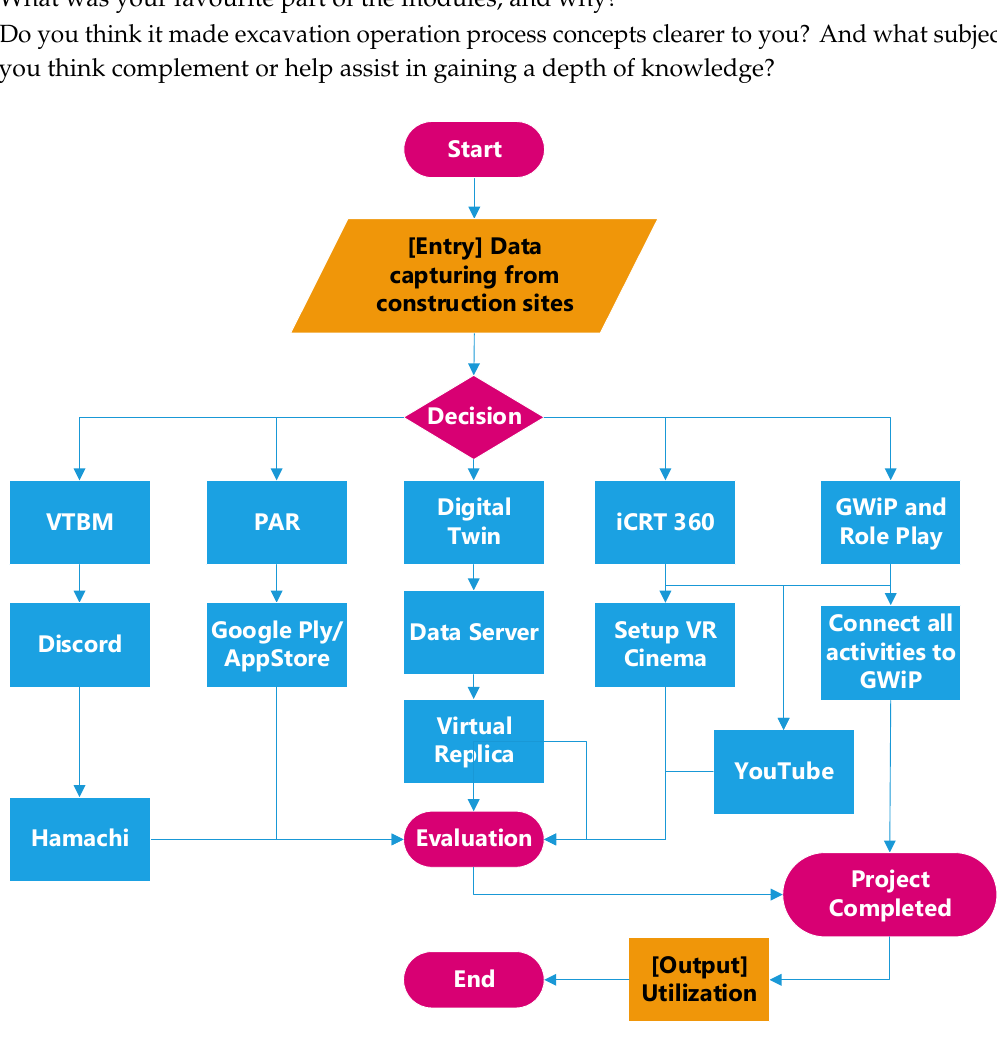
Figure 1. Flowchart of mixed reality modules developed for virtual education, including digital twin and online App. VTBM: Virtual Tunnel Boring Machine, PAR: Pilling Augmented Reality, iCRT: interactive reality tour, GWiP: Group WiKi Project.